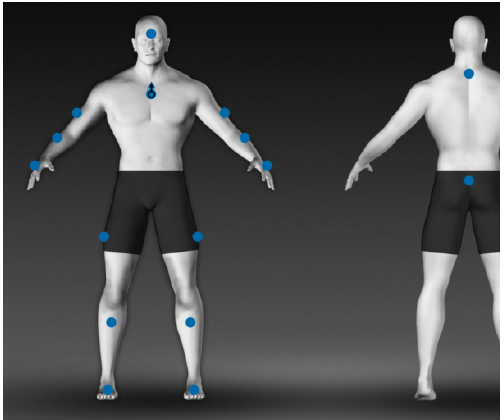
Figure 1. Sensor distribution over the body for each of the 77 subjects participating to the study.